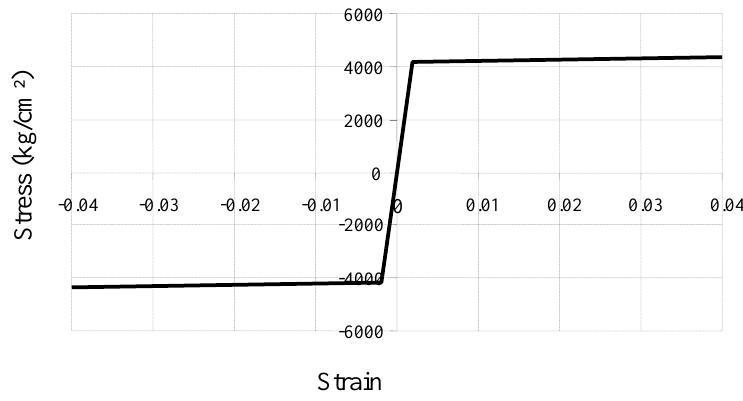
Fig. 12. Reinforcing steel constitutive